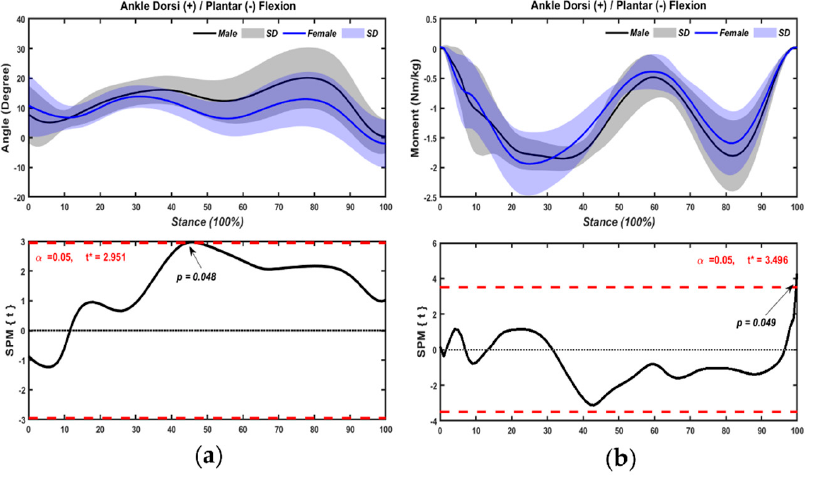
Figure 6. Kinematics (( a ), dorsi/plantar flexion angle) and kinetics (( b ), dorsi/plantar flexion moment) of ankle joint with chasse-step in sexes.